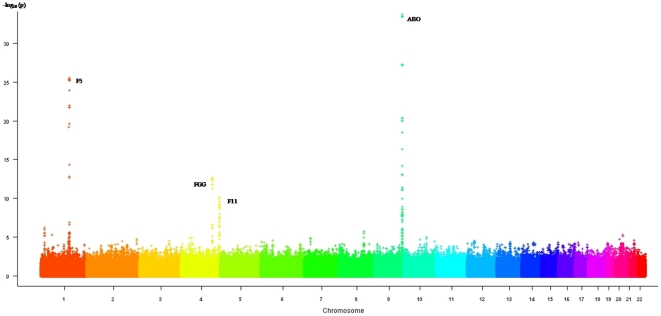
Manhattan plot of the association results from the combined analysis of two imputed GWAS data sets for 2,475,305 SNPs.